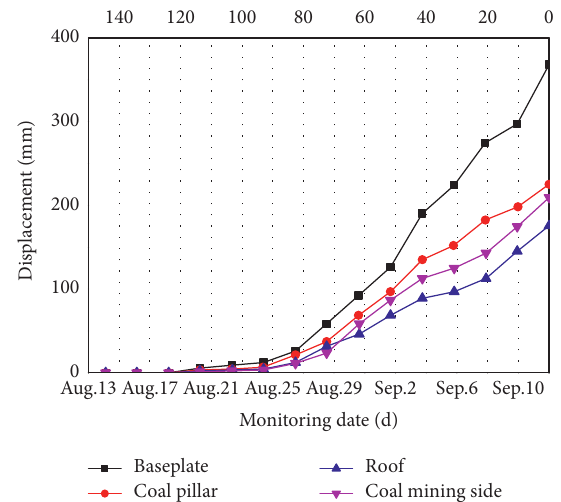
Figure 15: Hydraulic fracturing section: roof separation curve of 2# station.